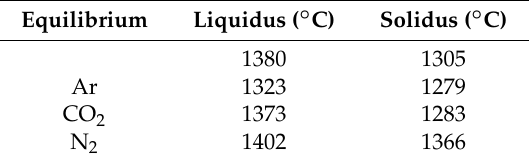
Table 2. Summary of the solidus and liquidus temperatures of the steel, determined from thermography in the three different atmospheres, and the predicted (from Thermo-Calc)